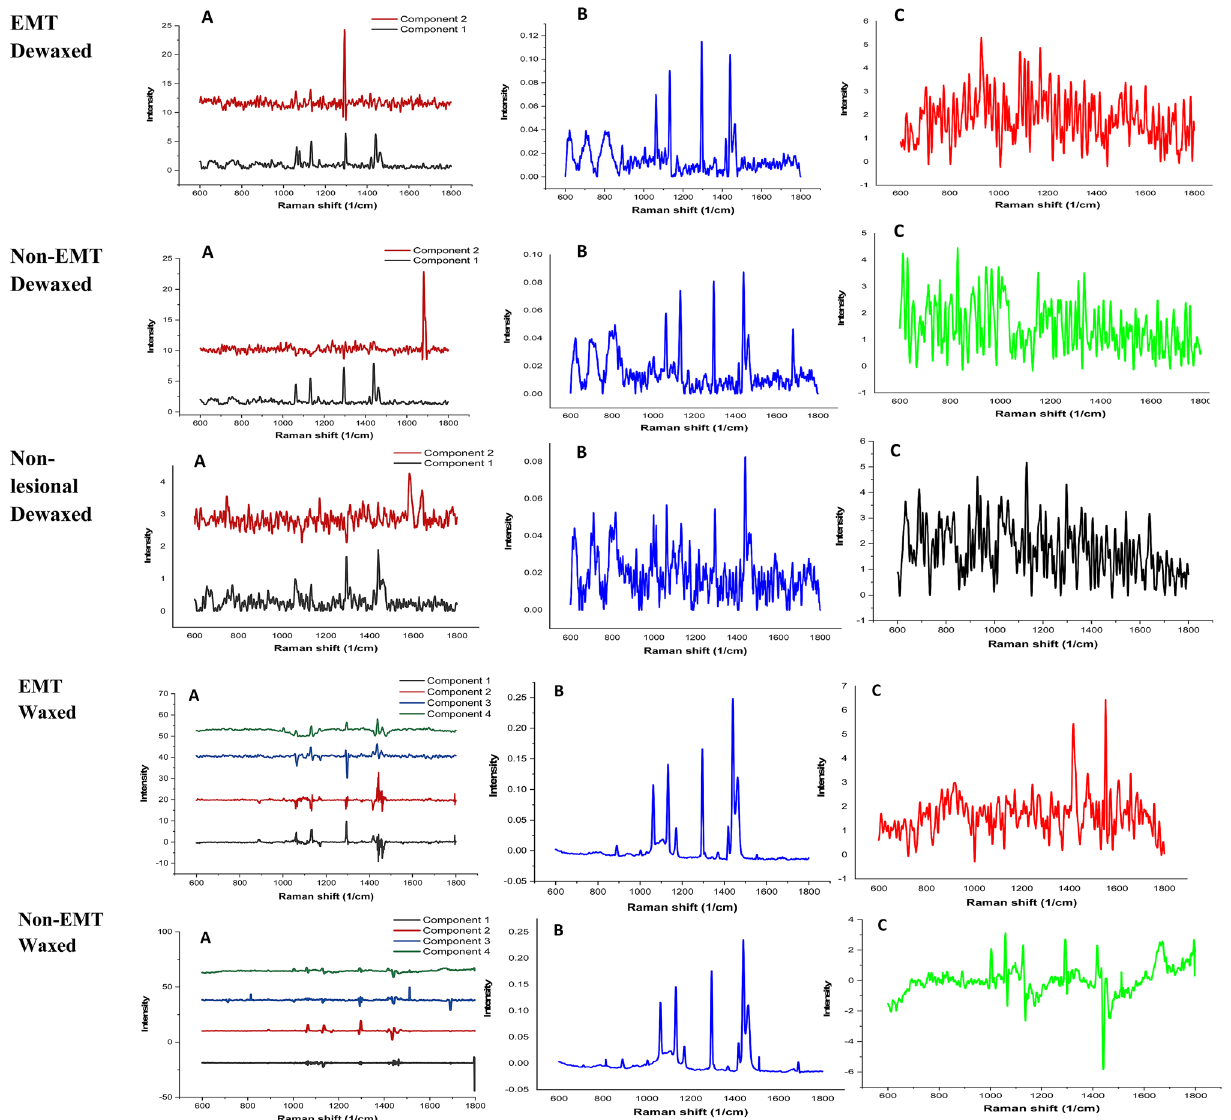
Figure 3. ( A ) The estimated paraffin components from ICA, ( B ) difference of before-after paraffin removal and ( C ) Raman spectra after paraffin higher intensity compared to that non-lesional tissue. Comparison of the relative intensity of non-lesional, EMT and non-EMT tissue are also included in Fig. 5. Waxed samples. The Raman spectra of lipid found in the waxed samples are depicted in Fig. 5 together with the peaks assignment. The Raman band observed at peak 938 cm −1 in EMT tissues and 1451 cm −1 in the non- EMT tissues are marker peaks of the CH group of lipid, showing 37% greater intensity in the non-EMT tissues compared to the EMT tissues. Phospholipid was found in both EMT and non-EMT tissues with slightly higher intensity in EMT tissues by 2% compared to non-EMT tissues. The C–C stretching of lipid was found at peak 1120 cm −1 for EMT tissues and 1078 cm −1 for non-EMT tissues, with greater intensity by 21% in EMT tissues compared to that of non-EMT tissues. A comparison of the relative intensity of both EMT and non-EMT tissue is shown in Fig. 5. Numerous studies have indicated that abnormal levels of lipids in tissues correlate with metastasis of various types of cancer, including breast cancer 36,37 . An early feature of carcinogenesis is the activation of lipid metabo- lism, being the hallmark of many types of cancer 36,58 . It has been reported that lipids have an important role in controlling the adhesion of cell and migration processes 38,59 , a matter supported by clinical data showing lipid- rich breast cancer to be responsible for half of the deaths of patients with cancer 59,60 . With EMT a process which acquires a mesenchymal phenotype with increased migratory features, present observation of high intensities of Raman bands corresponding to lipids in EMT tissues are seen to be in accordance with this.